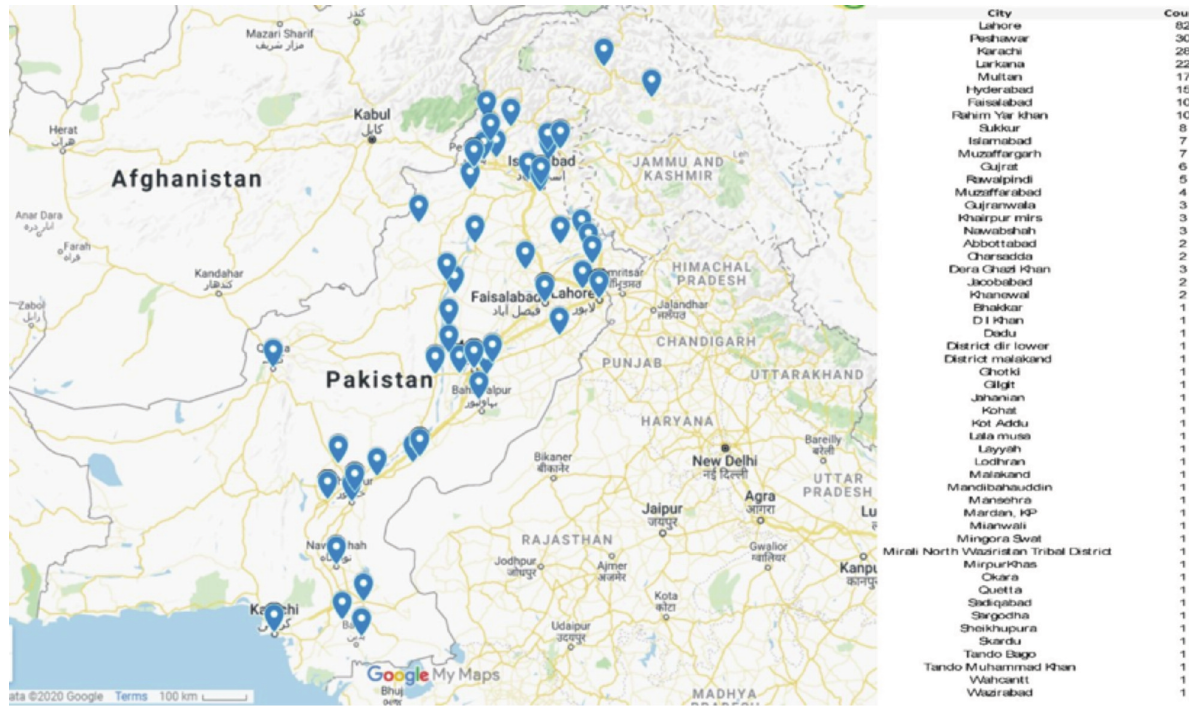
Representative map drawn on Google map showing distribution of survey responses received from various cities of Pakistan. Fig. 1: https://www.google.com/maps/d/u/0/edit?mid=1D51I7_DtReSqUsvi4vlfTZXDmp5wcefK&usp=sharing (accessed on 06th June 2020).